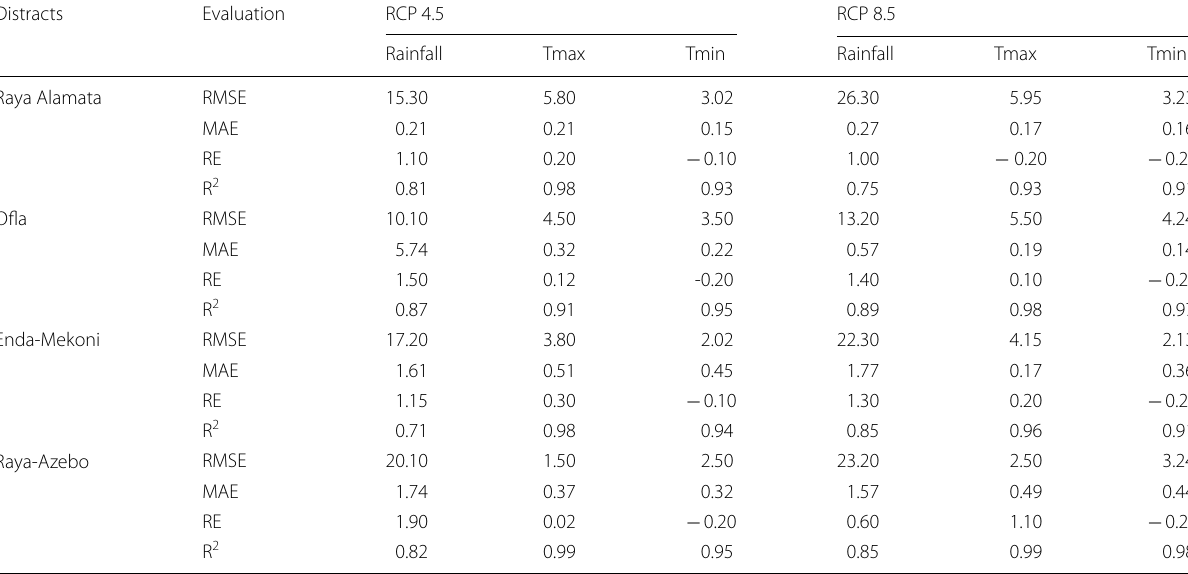
Table 5 Validation statistics of climate modeling performance Distracts